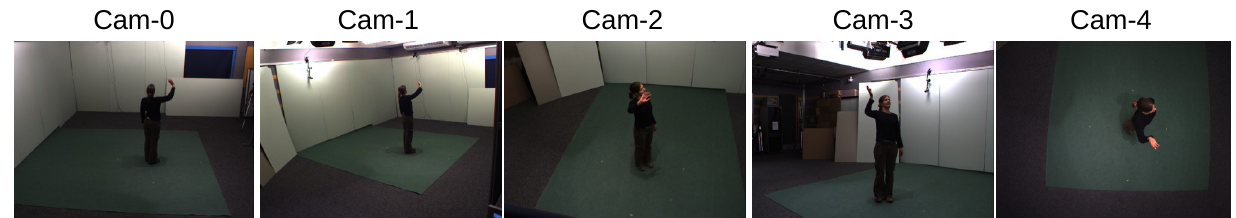
Figure 1. An example of all the camera views in the original IXMAS dataset.